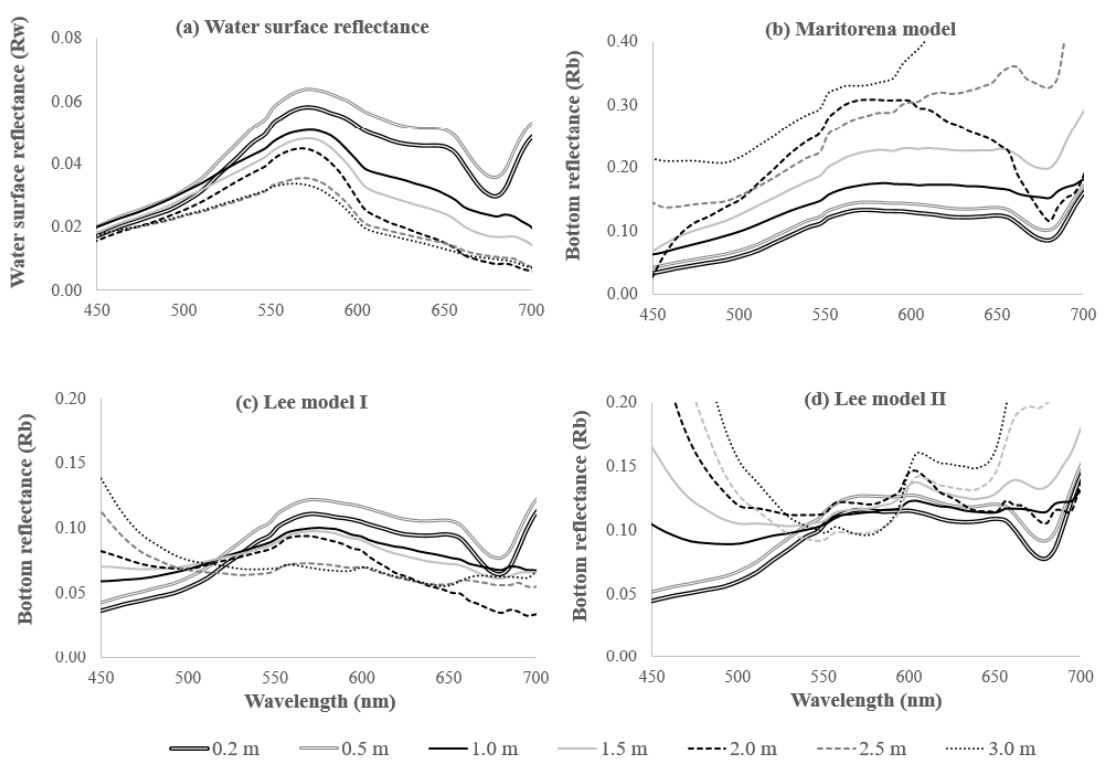
Figure 4. Sand reflectance spectra at various water depths before and after water column correction.